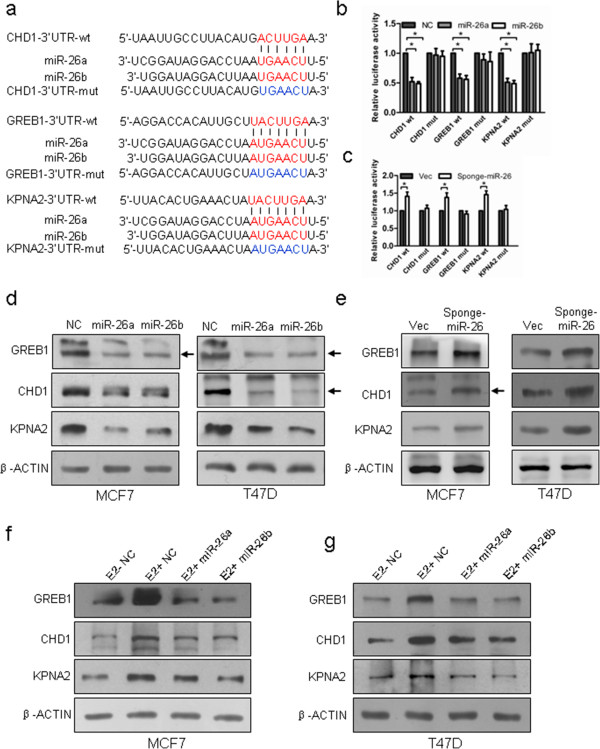
miR-26 directly targets CHD1, GREB1 and KPNA2 genes. (a) Putative miR-26-binding sequences in the 3′ untranslated region (UTR) of CHD1, GREB1 and KPNA2 mRNA. Mutations were generated on the CHD1, GREB1 and KPNA2 3′ UTR sequence in the complementary site for the seed region of miR-26. (b) Luciferase reporter assays in T47D cells, with co-transfection of wild-type (wt) or mutant (mut) 3′ UTR and microRNA (miRNA) as indicated. (c) Luciferase reporter assays in T47D cells, with co-transfection of wt or mut 3′ UTR and miRNA sponge as indicated. (d) Forced expression of miR-26a or miR-26b in MCF-7 and T47D cells decreased protein levels of CHD1, GREB1 and KPNA2 by western blot analysis. (d, e) After forced expression or depletion of miR-26, the expression of CHD1, GREB1 and KPNA2 protein were analyzed by western blot assay. (f, g) Western blotting analysis of the expression of CHD1, GREB1 and KPNA2 protein in 17β-estradiol (E2)-treated MCF-7 and T47D cells transfected with the indicated miRNA molecules. *P < 0.01.